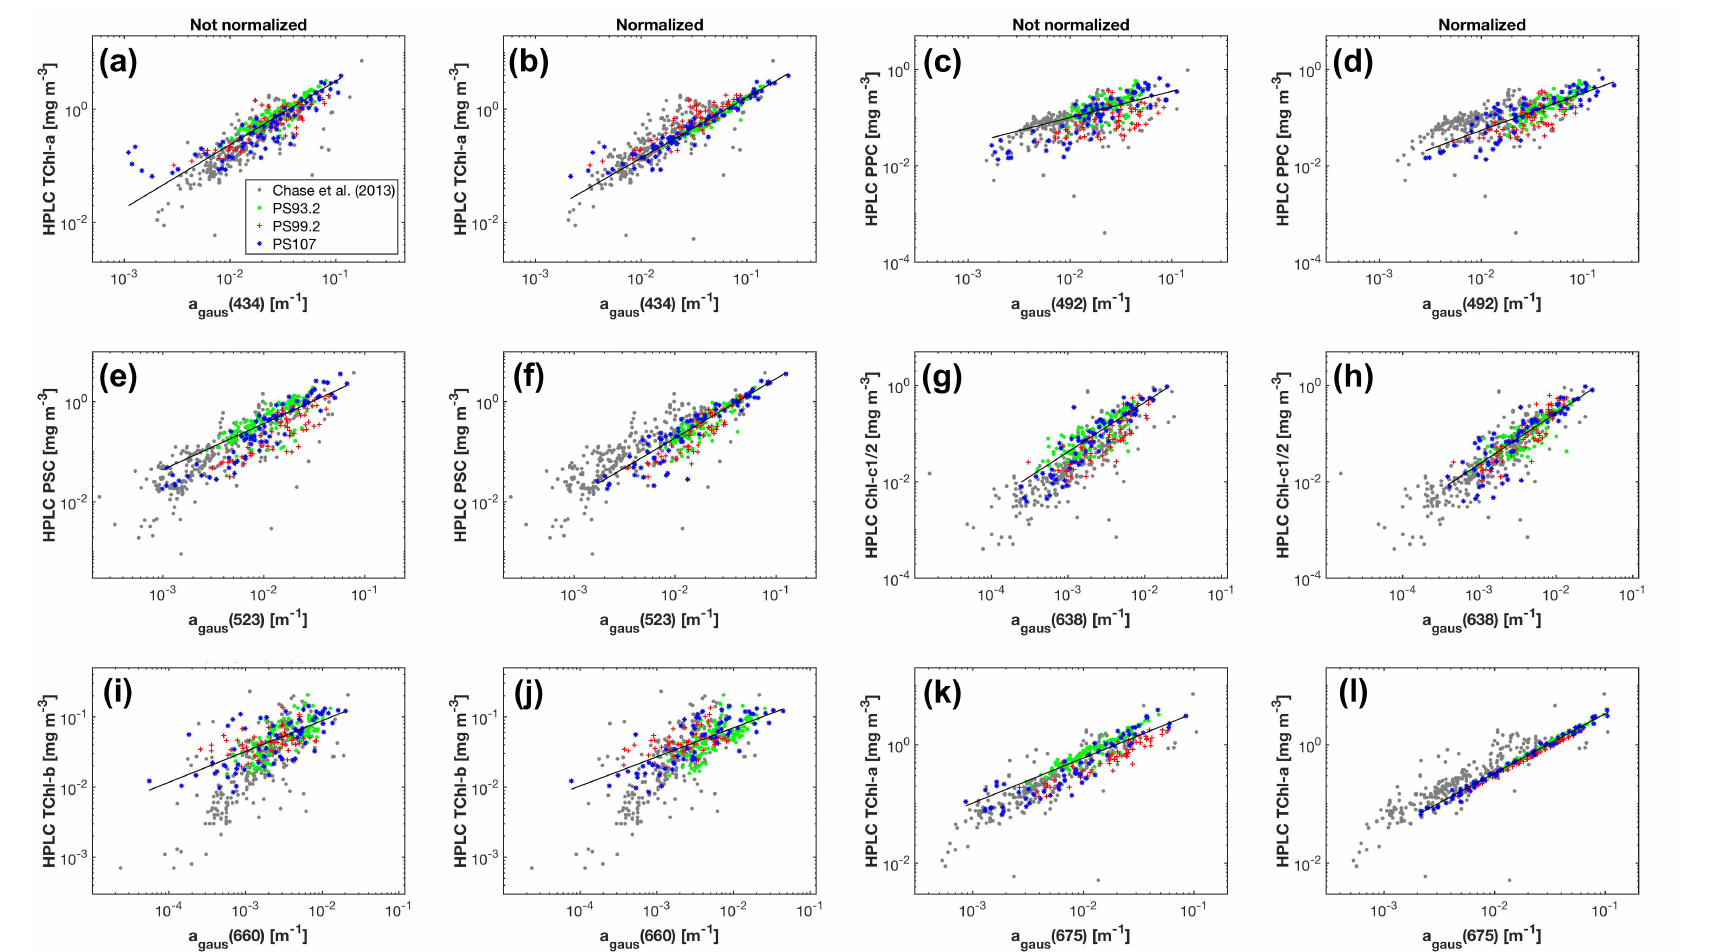
Figure 5. Concentrations of phytoplankton pigments measured by HPLC versus the magnitudes of the corresponding Gaussian functions obtained from the Gaussian decomposition of both a ph ( λ ) ( a , c , e , g , i ) and ˆ a ph ( λ ) ( b , d , f , h , j , l ). The results of Chase et al. [22] are based on a ph ( λ )